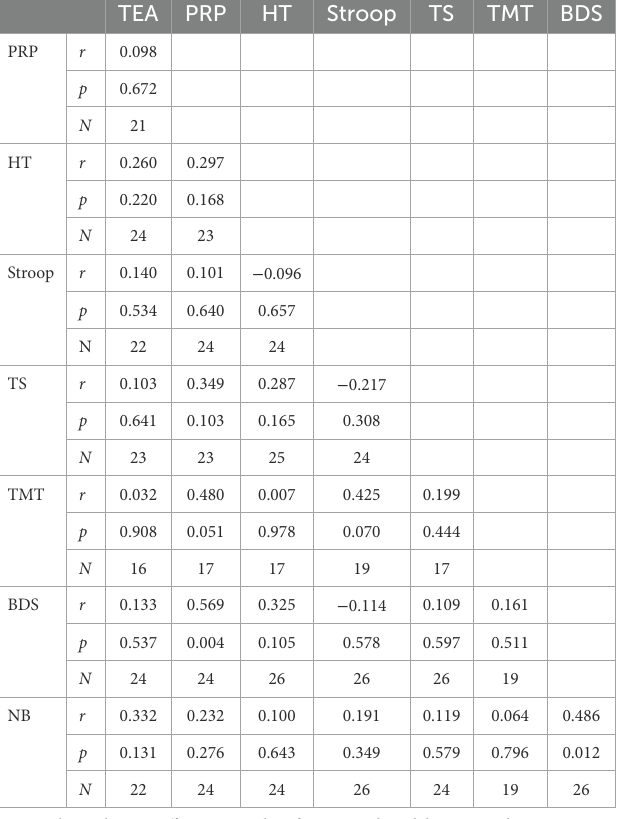
TABLE 5 Young adults correlation matrix of the average executive function z -score measures. TEA PRP HT Stroop TS TMT